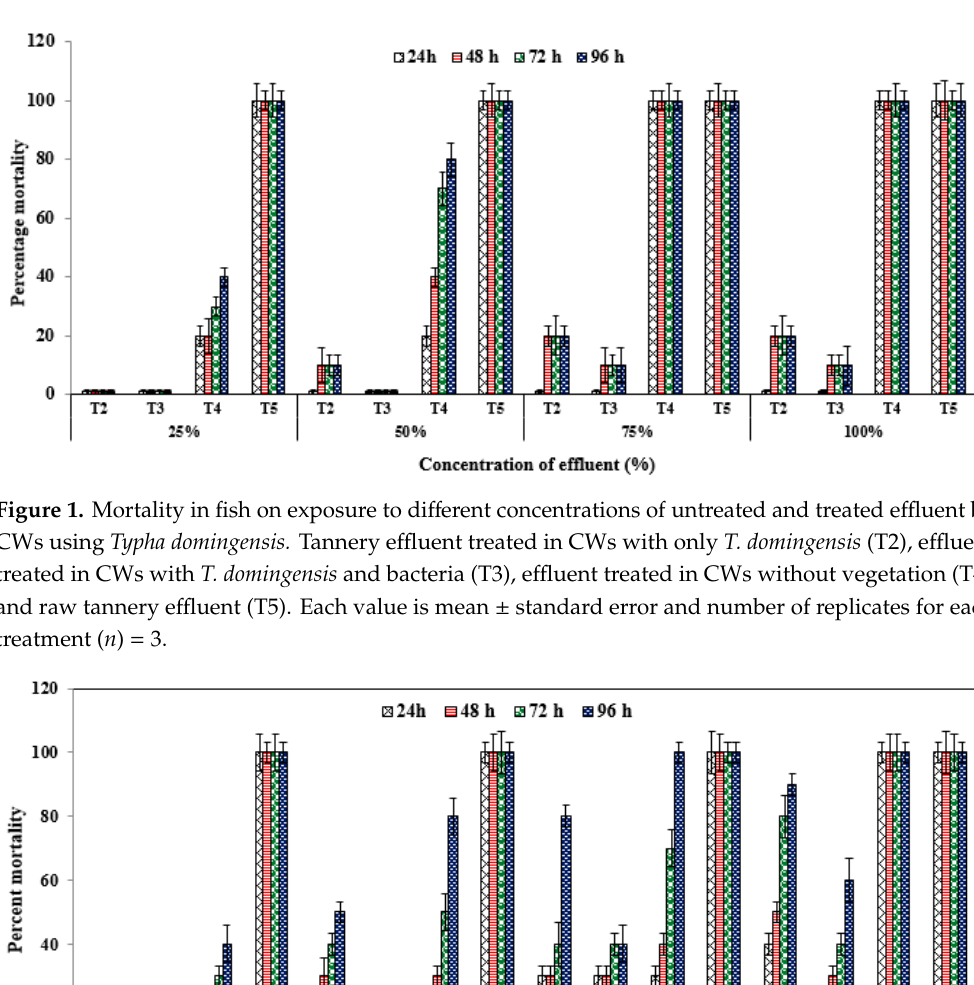
Figure 3. Mortality in fish on exposure to different concentrations of untreated and treated effluent by CWs using Brachiaria mutica. Tannery effluent treated in CWs with B. mutica only (T2), effluent treated in CWs with B. mutica and bacteria (T3), effluent treated in CWs without vegetation (T4), and raw tannery effluent (T5). Each value is mean ± standard error and number of replicates for each treatment ( n ) = 3. Stocked in T3 (effluent treatment by combined use of L. fusca and bacteria) at 50% effluent concentration, while the maximum percentage mortality observed was only 10% in higher effluent concentrations (100%). Observations for T4 treatment were the same as described above. 3.2. Toxicity of Raw Tannery Effluent Raw effluent caused high acute toxicity and 100% mortality in exposed fish, even at dilutions up to 25% (Table 2). The fish died immediately after release to raw effluent (T5). In contrast, no mortality of fish was observed in tap water that was set as a positive control (T1).